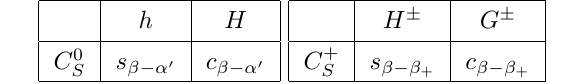
Table 7 . Coe(cid:14)cients for the couplings between one scalar and two gauge bosons. where there is an implicit summation on S 00 . The loop functions B